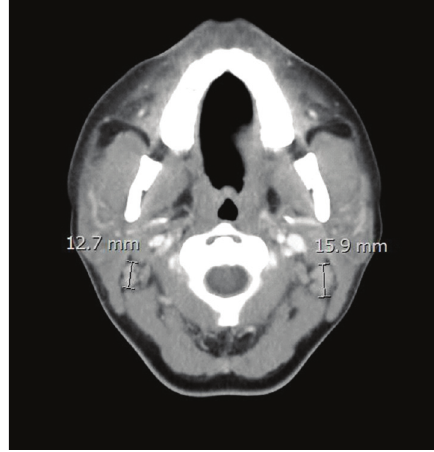
F 1: Cervical lymphadenopathy associated with Kikuchi- Fujimoto’s Disease.